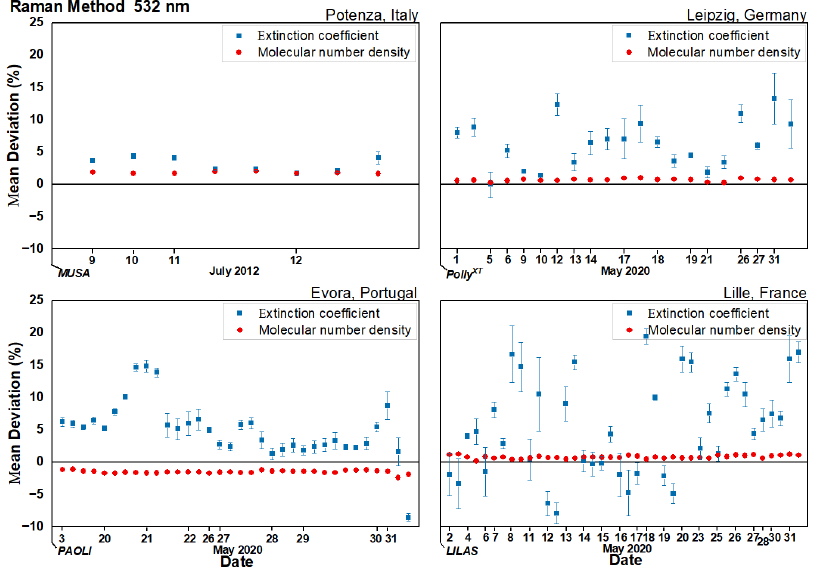
Figure 2. Same as Figure 1, but for 532 nm.